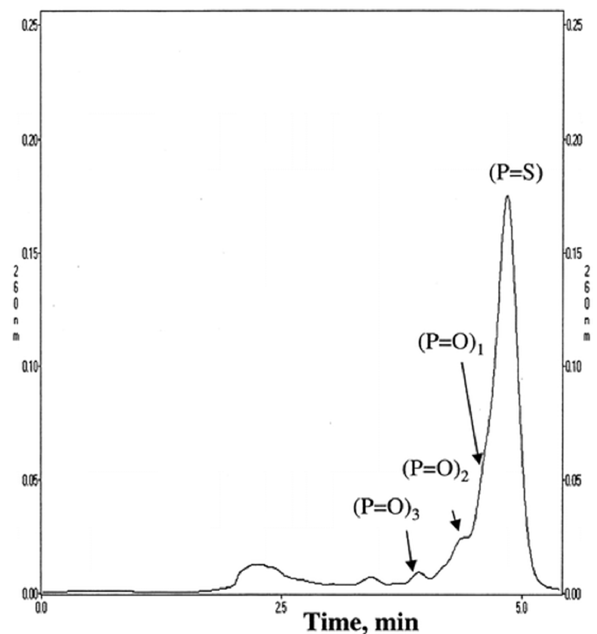
Figure 6. Representative runs without optimized conditions. Column: Resource Q 1 mL (6.5 mm i.d. × 30 mm length). Buffer A: 20 mM NaOH. Buffer B: 20 mM NaOH/2.5 M NaCl, flow rate 5 mL/min, gradient 0−100% B in 20 CV, loading 50 µg (50 µl of 1 mg/mL ISIS 2302) (Reprinted from Ref. [62] Open Access article).